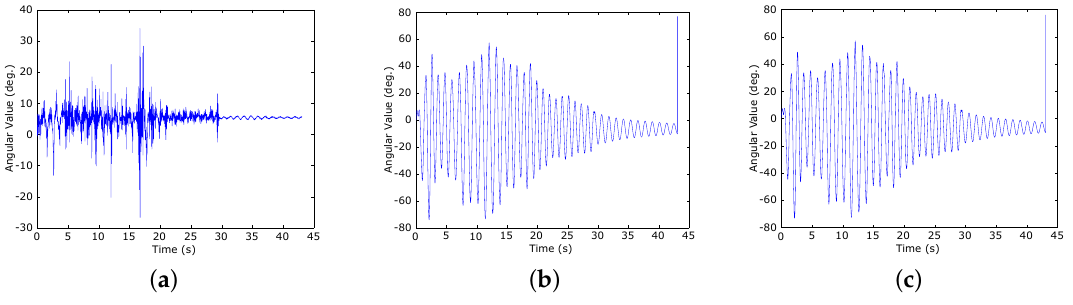
Figure 4. The Euler pitch angles calculated using a separate accelerometer sensor, our proposed solution, and the encoder. ( a ) Separate accelerometer sensor; ( b ) Our proposed solution; ( c ) The